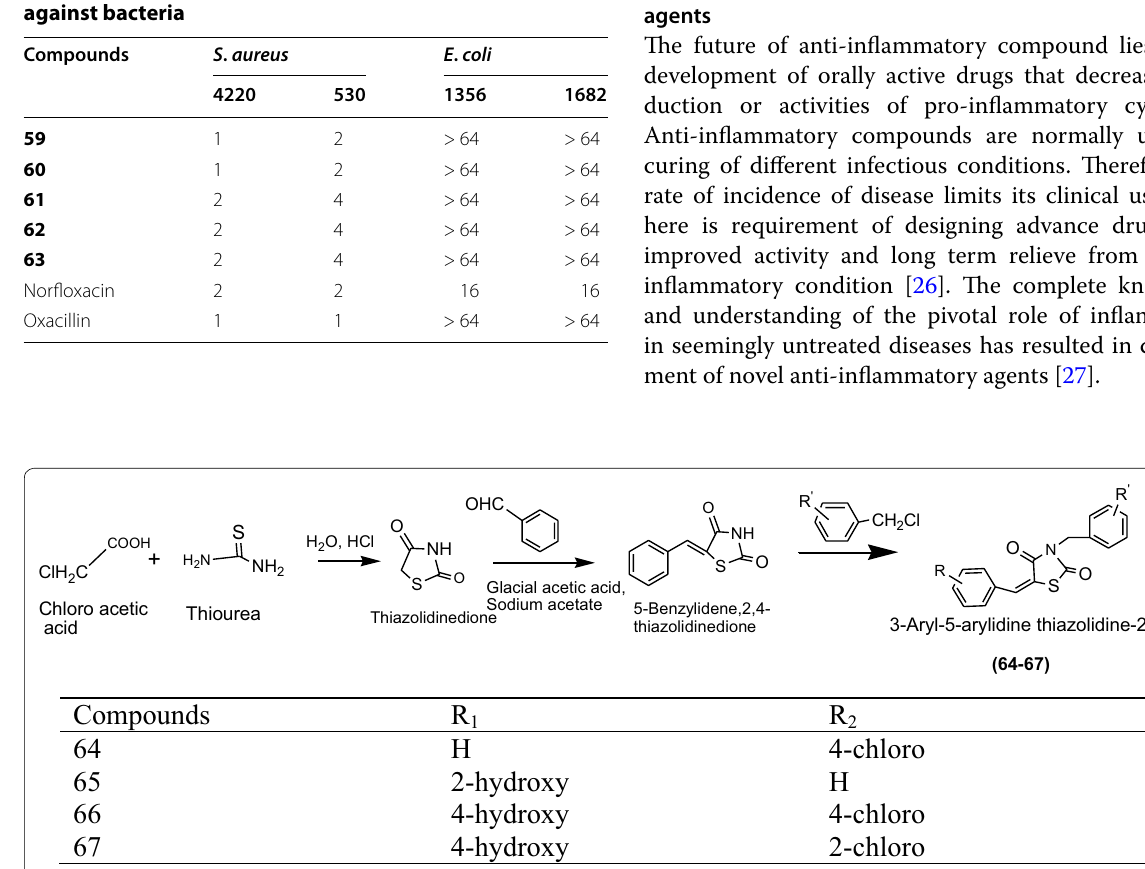
Table 18 Inhibitory activities of novel compounds